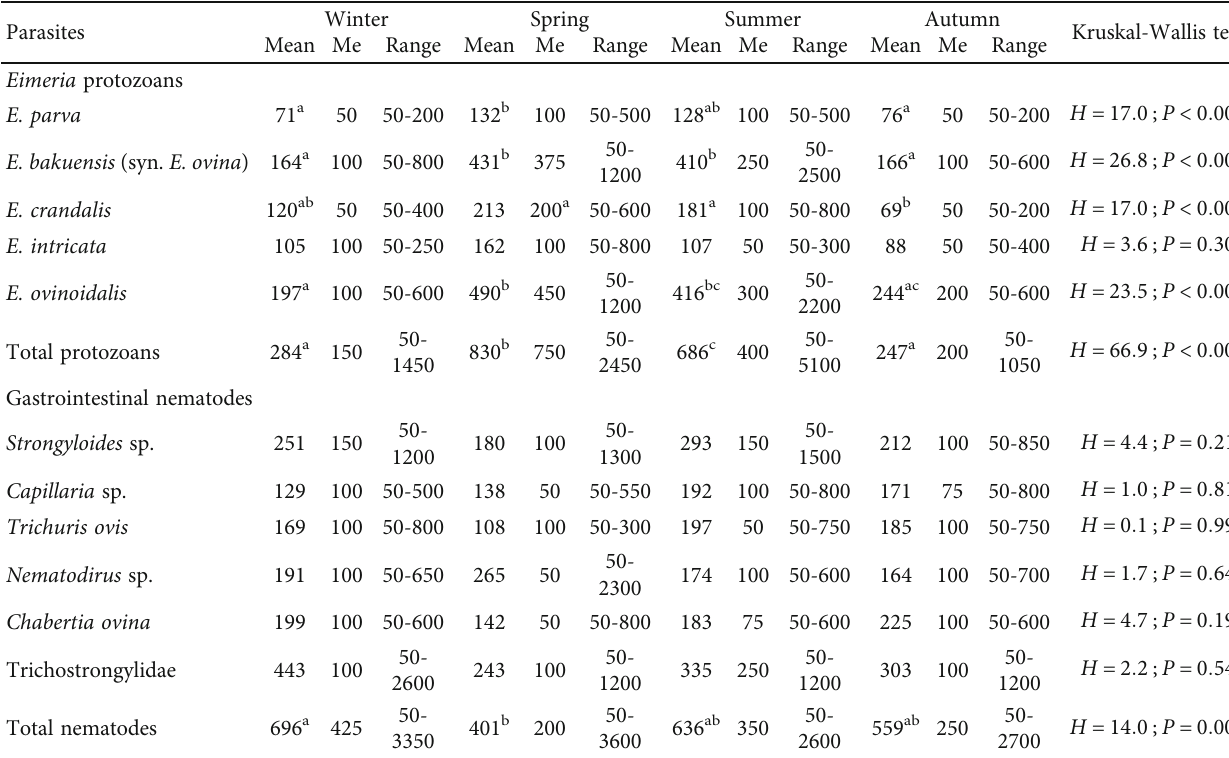
Table 4: Intensity of infection with Eimeria protozoans (oocysts per gram (OPG)) and gastrointestinal nematodes (eggs per gram (EPG)) in mou fl ons in speci fi c seasons. Winter Spring Parasites Range Mean Me Range Mean Me Range Eimeria